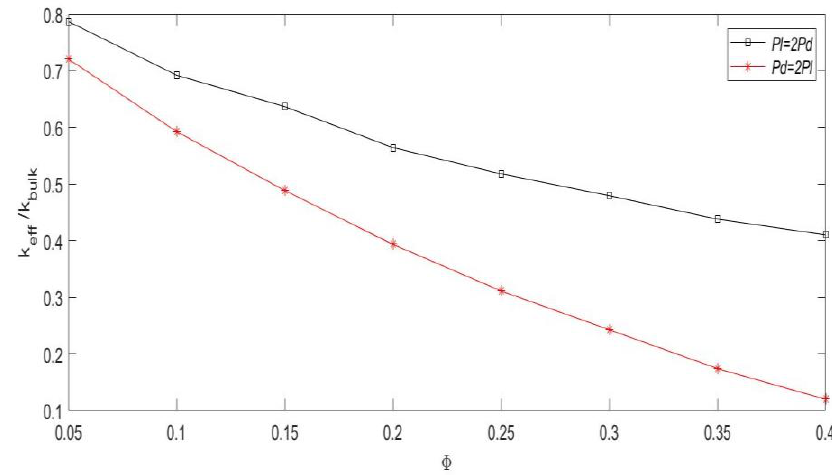
Figure 13. Rectangle pores with the length along the abscissa.